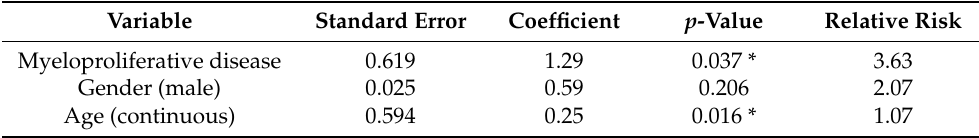
Figure 6. Impact of underlying disease on survival, n = 46. Table 5. Multivariate Cox regression analysis of mortality: model A. Patients with BCS, n =